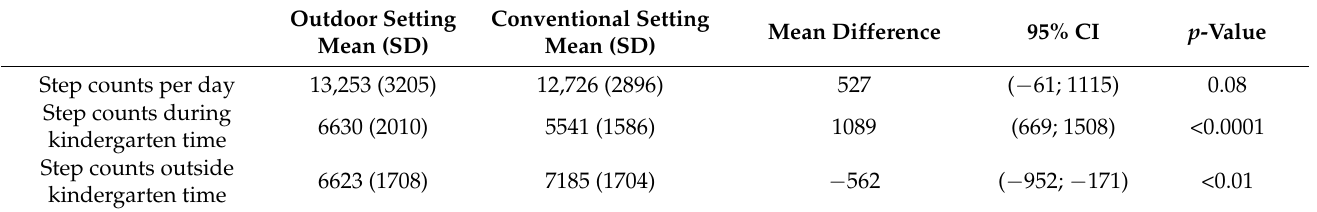
Figure 2. Differences in step counts (mean, 95% CI) between children in outdoor and conventional kindergarten setting (n = 74). Table 2. Difference in physical activity behaviour between the outdoor setting and the conventional setting (n = 74).